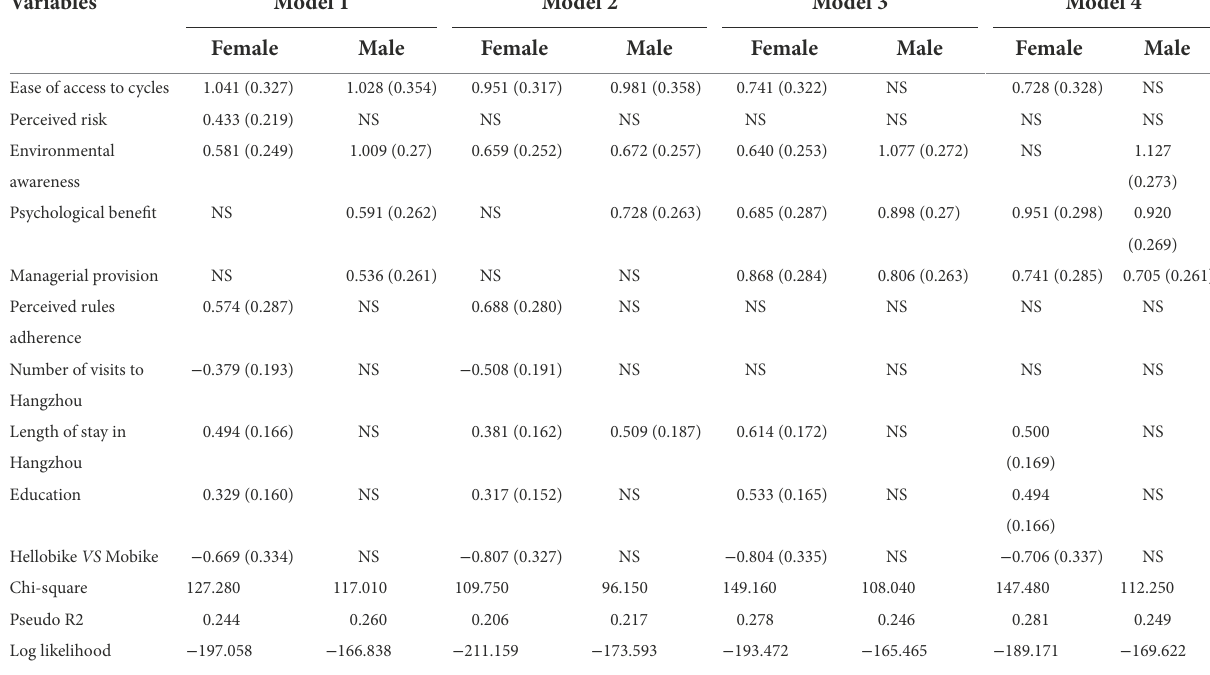
TABLE 5 Ordered logistic regression analysis model results ( n =